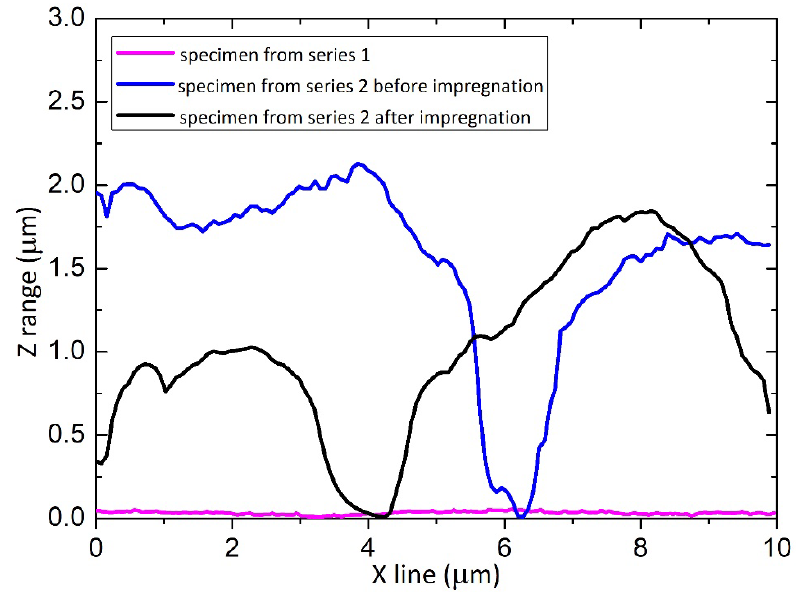
Figure 7. Profiles obtained from AFM topographies along the selected line for the specimen from Series 1, the specimen from Series 2 before impregnation, and the specimen from Series 2 after impregnation.